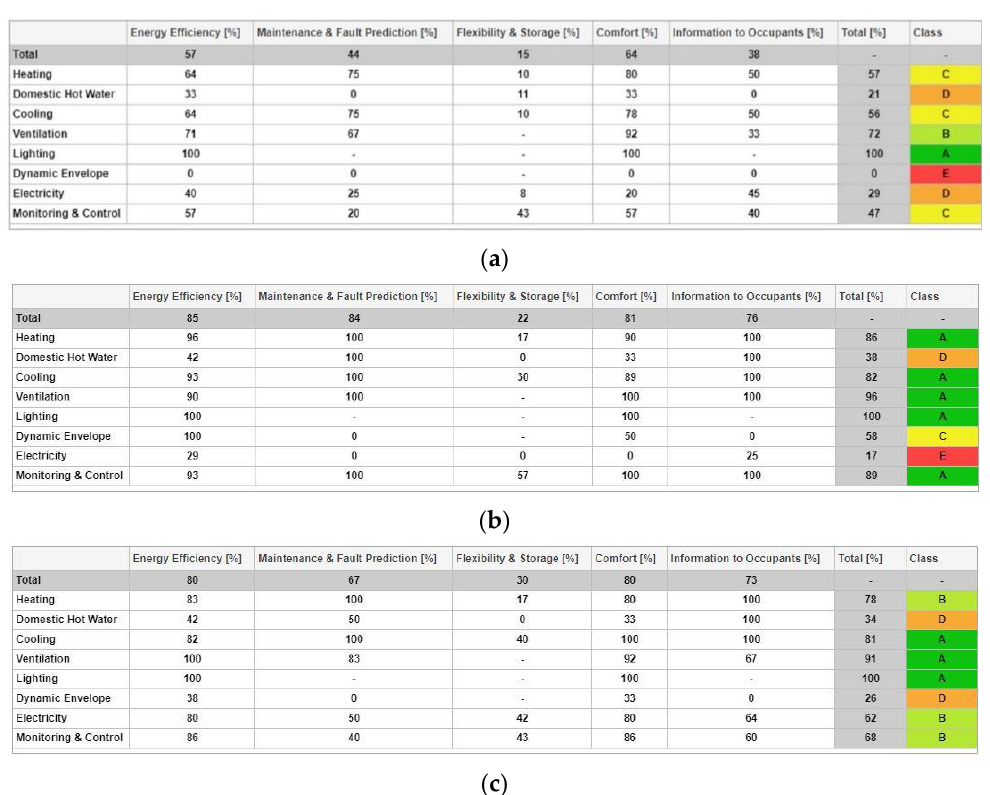
Figure 11. Performance matrix results of Comfort Improvements Package in ( a ) Case A, ( b ) Case B, and ( c ) Case C.